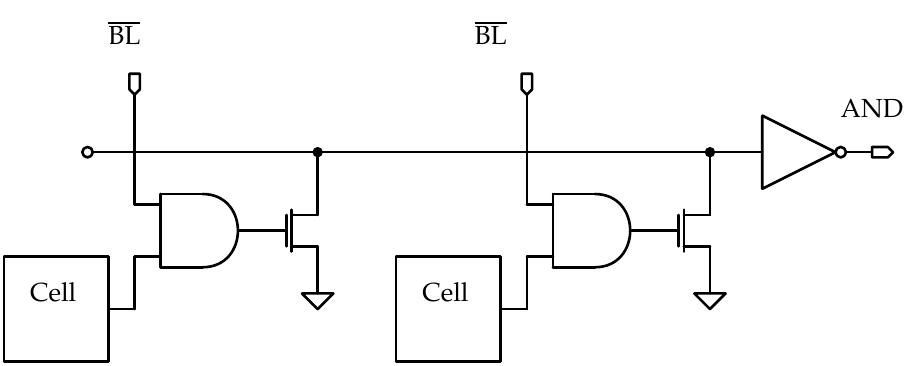
Figure 7. The AND line. The AND gates outputs are connected to a wired-OR line through pull-down transistors. The signal on the line is then inverted to the AND result. The AND gates results are selected through BL by the